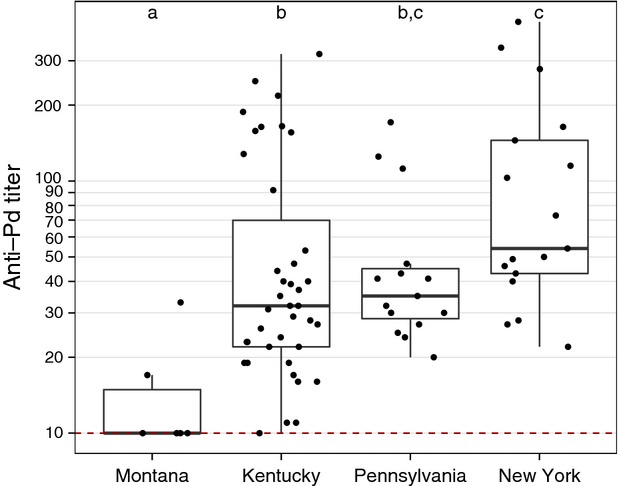
Comparison of anti-Pd antibody titers determined for little brown myotis (Myotis lucifugus) captured in spring across North America. Anti-Pd titers are lowest, but still detectable, in Montana (WNS-negative), followed by Kentucky (WNS-positive since 2011), then Pennsylvania (WNS-positive since 2008), and the highest titers were found in New York (WNS-positive since 2006). Data are presented as quartiles, median (black line), and whiskers that represent 1.5 times the interquartile range. Titers ≤ 10 are considered negative for Pd reactive antibodies. Titers differed significantly between locations not sharing common letters (P < 0.05).